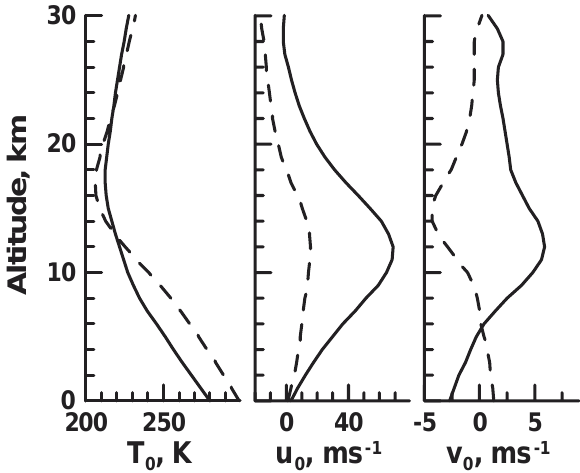
Fig. 3. Background profiles of temperature (left), zonal (middle) and meridional (right) wind velocities in January (solid lines) and July (dashed lines) at